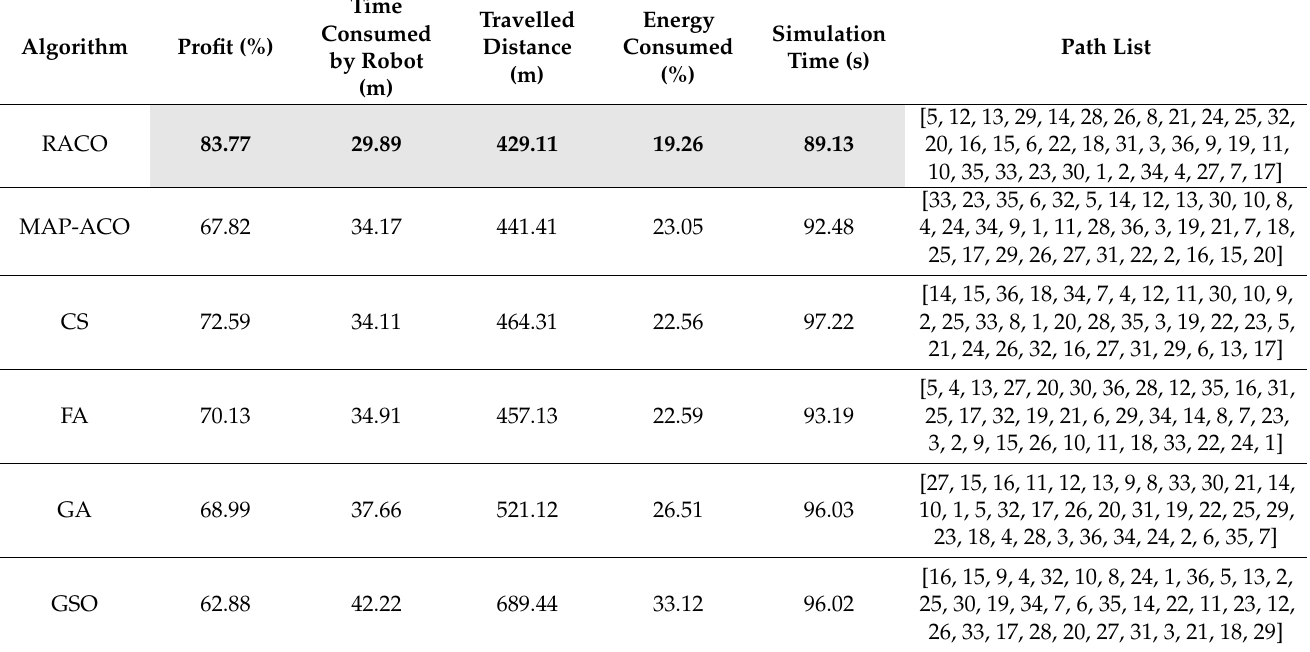
Table 6. Simulation results of each algorithm (best) based on phases 2 and